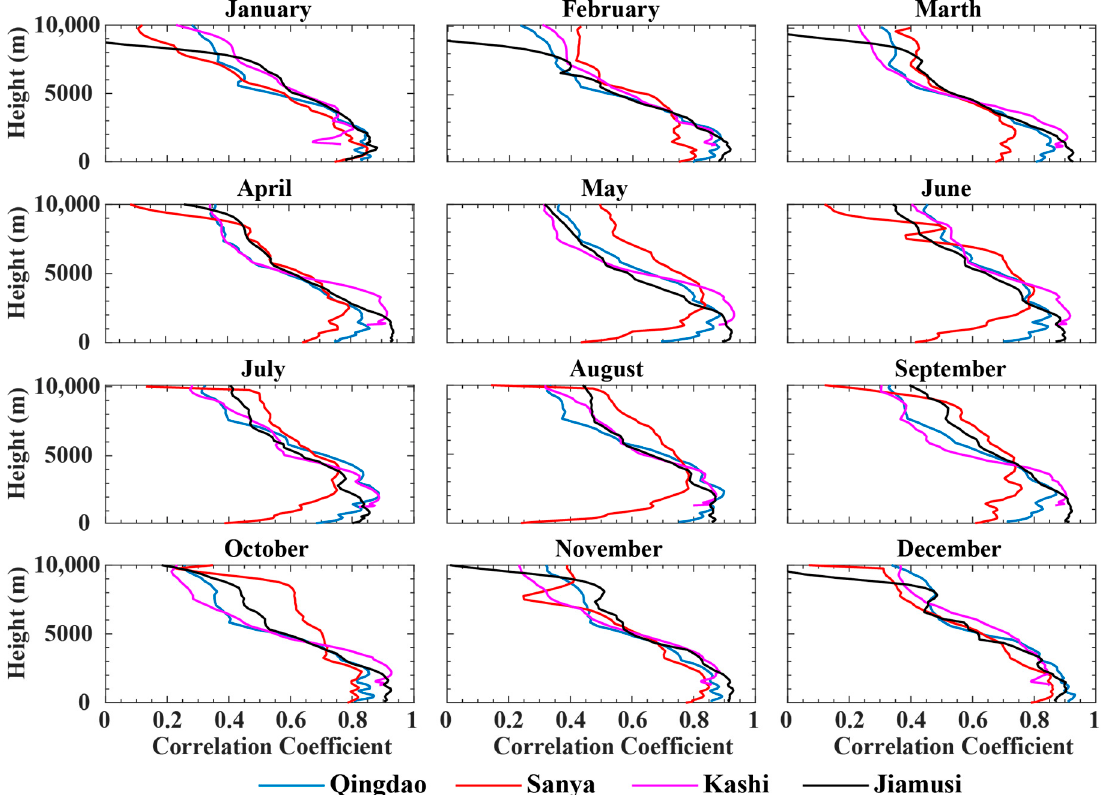
Figure 3. Variations of the correlation coefficients with height between zenith wet delay and water vapor pressure at different months of Qingdao, Sanya, Kashi, and Jiamusi station, respectively. The horizontal axis denote the correlation coefficients, the vertical axis denote heights in meters.